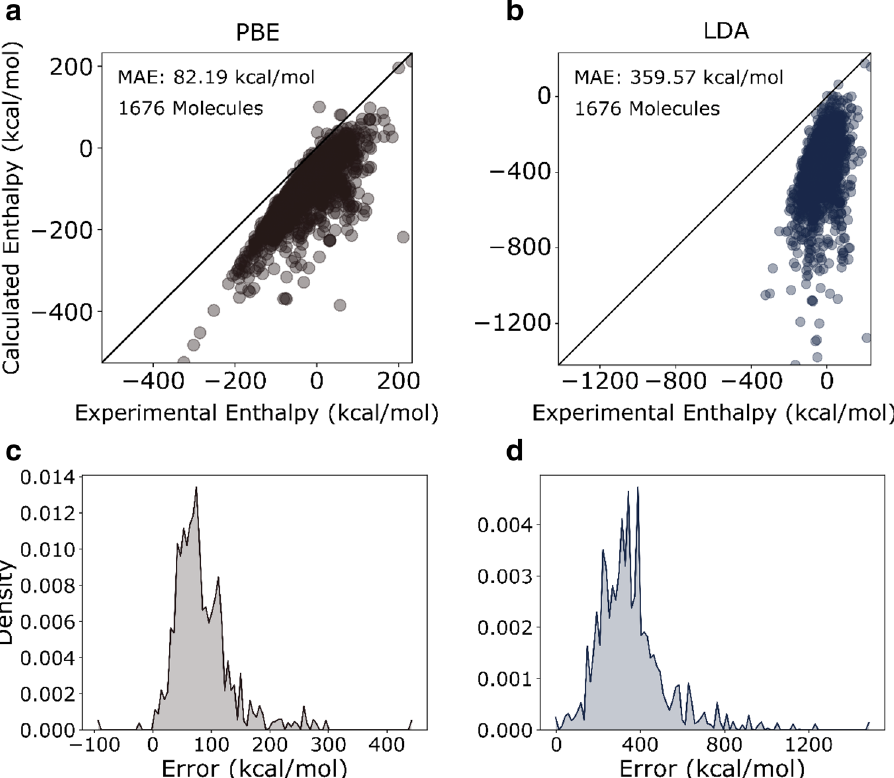
Figure 1. Parity plot of calculated formation enthalpy for 1676 gas species using the ( a ) PBE and the ( b ) LDA functional at 298.15 K and 1 atm versus experimental enthalpies of formation. Population density of errors in enthalpy of formation (298.15 K, 1 atm) using the ( c ) PBE and ( d ) LDA